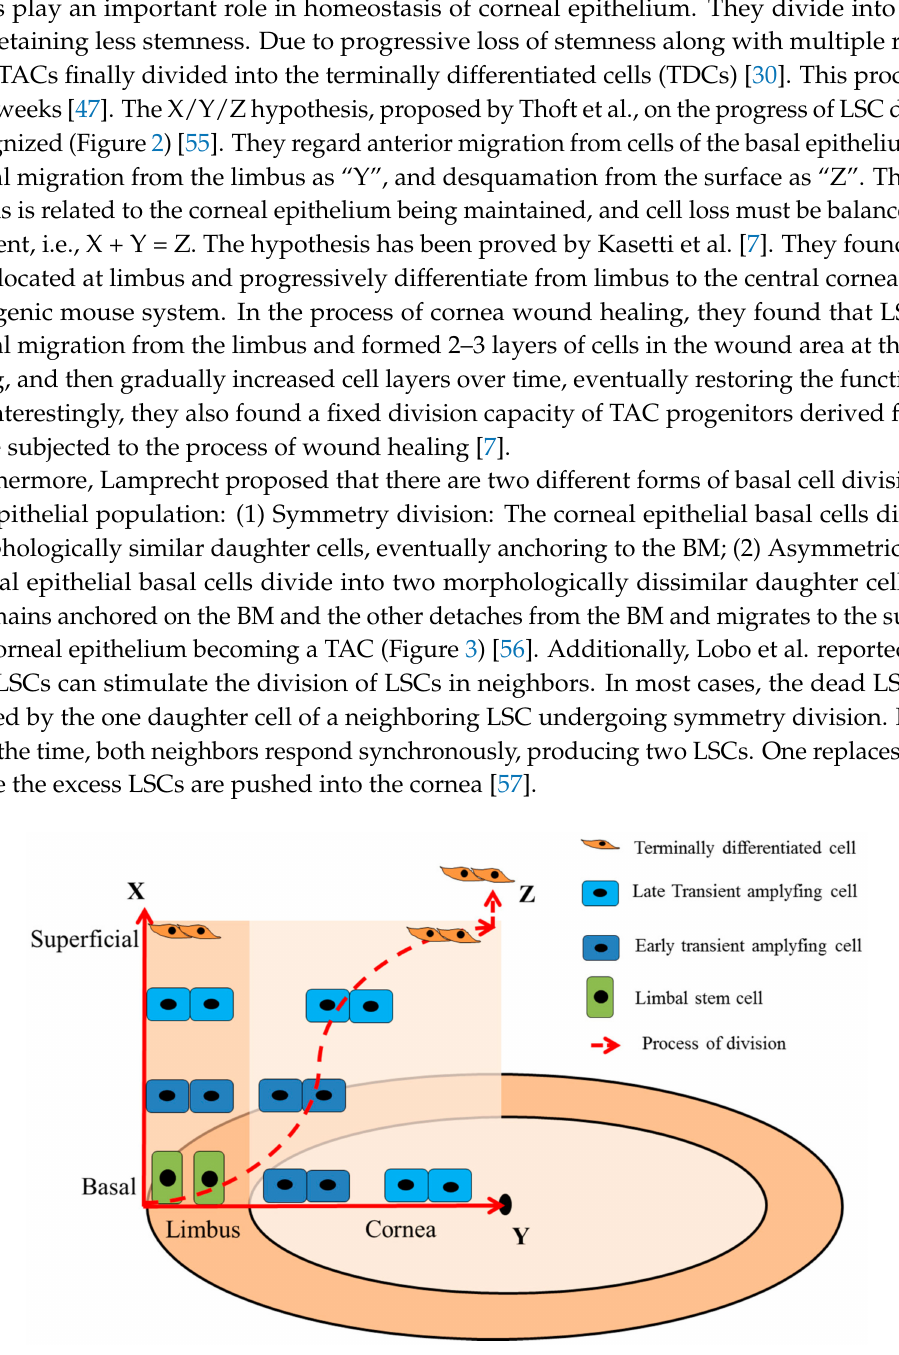
Figure 2. Simplified model of X/Y/Z hypothesis. X: anterior migration of the cells from the basal epithelium; Y: centripetal migration from the limbus; Z: desquamation from the surface. X + Y =